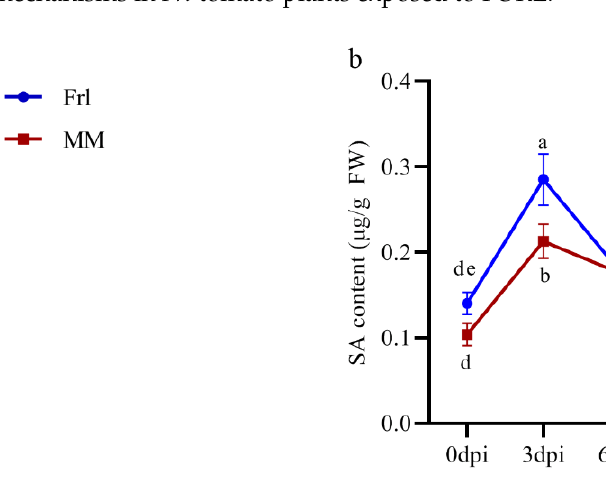
Figure 9. Fluctuations in ( a ) JA and ( b ) SA as a function of days after FORL infection in Frl tomato and MM tomato. JA, jasmonic acid; SA, salicylic acid; Frl , ‘19912’; MM, ‘Moneymaker’; dpi, days post-infection. Different letters indicate siginificant